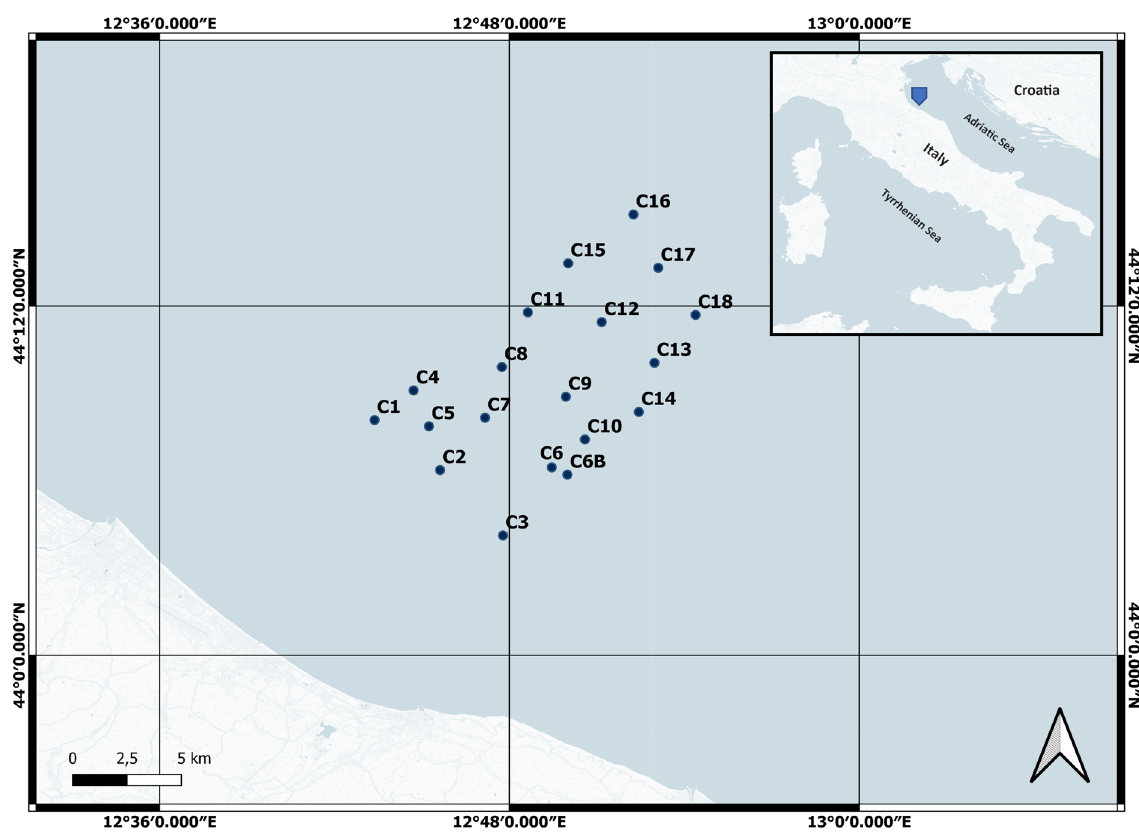
Figure 1. Sampling site and offshore study area. Sampling sites (both for water and sediment) are represented as blue